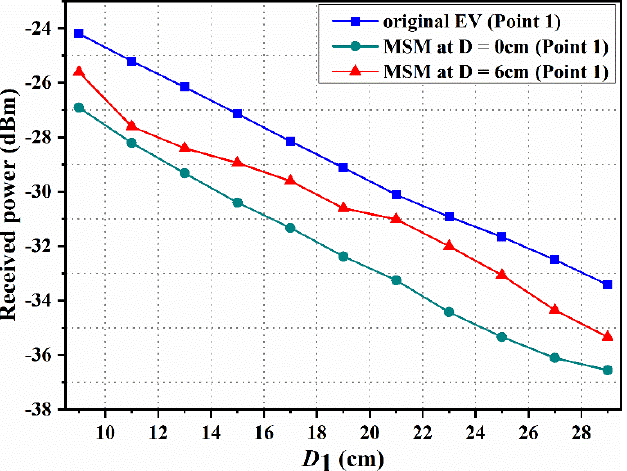
Figure 9. Measured magnetic field at point 1 when the MSM is placed on the top of the Rx coil. The magnetic field strength at D = 0 and 6 cm (point 2) is shown in Figure 10. Com- pared with the original EV system, the magnetic field strengths are reduced when the MSM is used in the EV-WPT system. Additionally, the magnetic field strength at D = 0 cm is better than that at D = 6 cm. Based on the above analysis, it is found that the MSM has a good shielding performance when it is close to the Rx coil when the measured position is fixed. The magnetic field decreases from − 30.64 to − 33.91 dBm at D = 0 cm, and decreases from − 30.64 to − 31.49 dBm at D = 6 cm when D1 = 9 cm. In summary, the magnetic field intensity of the plane decreases when the MSM is added to the top of the EV-WPT system.